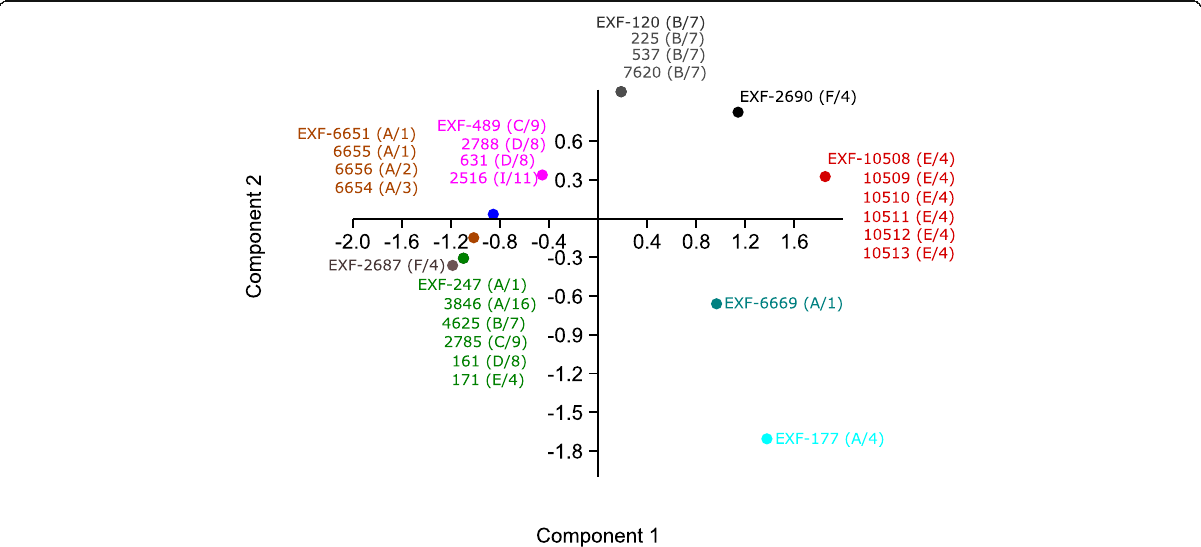
Fig. 7 Principal component analysis of Hortaea werneckii growth at different temperatures on solid malt extract agar. Strains with the same temperature patterns are coloured the